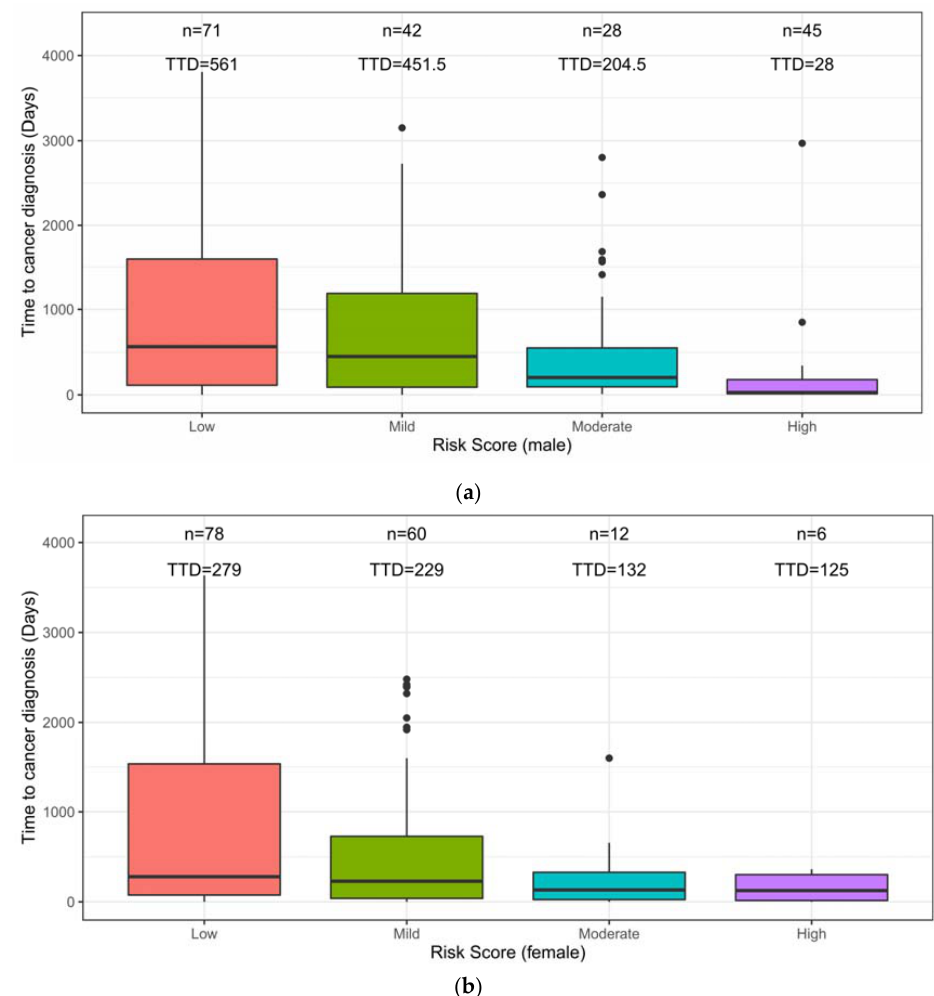
Figure 4. ( a ) Time to diagnosis (TTD) for cancer cases with different levels of risk (male). The median TTD is inversely correlated to the risk score: when a case is predicted with a higher risk score, a shorter TTD can be expected, thus a shorter time for additional investigation could be suggested. ( b ) Time to diagnosis (TTD) for the cancer cases with different levels of risk (female). The median TTD is inversely correlated to the risk score: when a case is predicted with a higher risk score, a shorter TTD can be expected, thus a shorter time for additional investigation could be suggested.